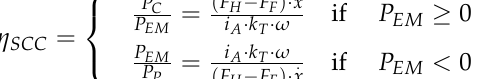
Figure 8. Experimental model validation: ( a ) Commanded motor speed; ( b ) motor speed; ( c ) piston position; ( d ) actuator’s bore-side pressure; ( e ) actuator’s rod-side pressure; and ( f ) accumulator pressure.